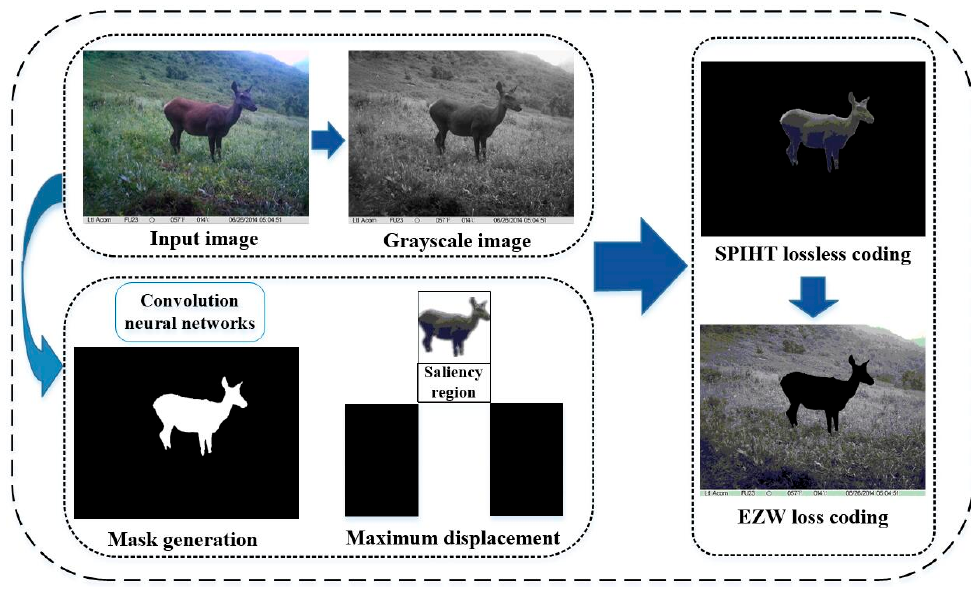
Figure 3. Structure of wildlife image progressive transmission process.